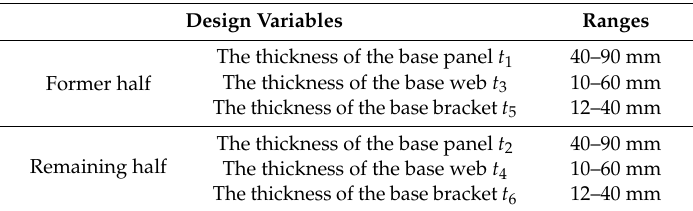
Figure 9. The impedance curves before and after pre-processing. As shown in Figure 9, the red line denotes the real impedance curve, which fluctuates significantly under different frequencies. The black line is the impedance curve after the pre- processing operation, which is smooth and the minimum value of the original curve remains the same. The blue line is the required impedance curve under different frequencies. Moreover, the allowance weight for this case is 3.027t and the maximum iteration of this case is set to be 50. To eliminate the randomness of the initial samples and the genetic algorithm, all methods use the same 60 initial LHS samples and the same setups of the genetic algorithm. Moreover, all the methods are repeated 20 times to avoid randomness occurring even though the setups are the same. The statistical optimization results of this problem with all compared methods of under 20 runs are summarized in Table 9. Furthermore, the detailed design variables, optimal, and weights of all runs are listed in Table A1 in the Appendix.